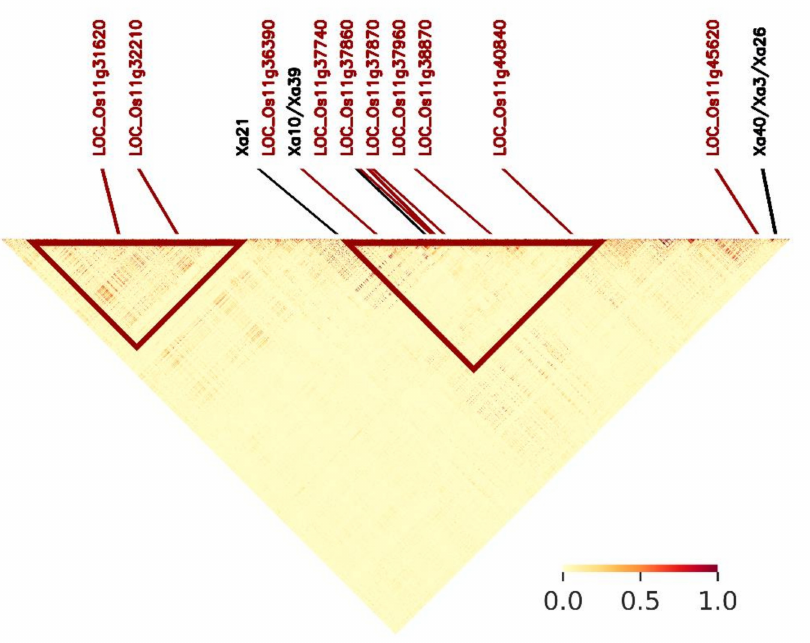
Figure 6. Linkage disequilibrium (LD) heatmap for chromosome 11 (region 17–29Mb) indicating chromosomal locations of six previously mapped R ( Xa ) genes and ten MSU annotated genes (LOC_Os prefix) that contain significantly associated SNPs highlighted by GWAS that are: (i) greater than LD decay threshold (61 Kb) away from R genes; and (ii) described by G O categorizations as having stress response functionality. A lack of red areas on the heatmap indicates the generally low levels of LD for this chromosome. Red triangles indicate densely clustered regions of significantly associated SNPs. Pointers show map positions (bottom) and relative position on chromosome within the region